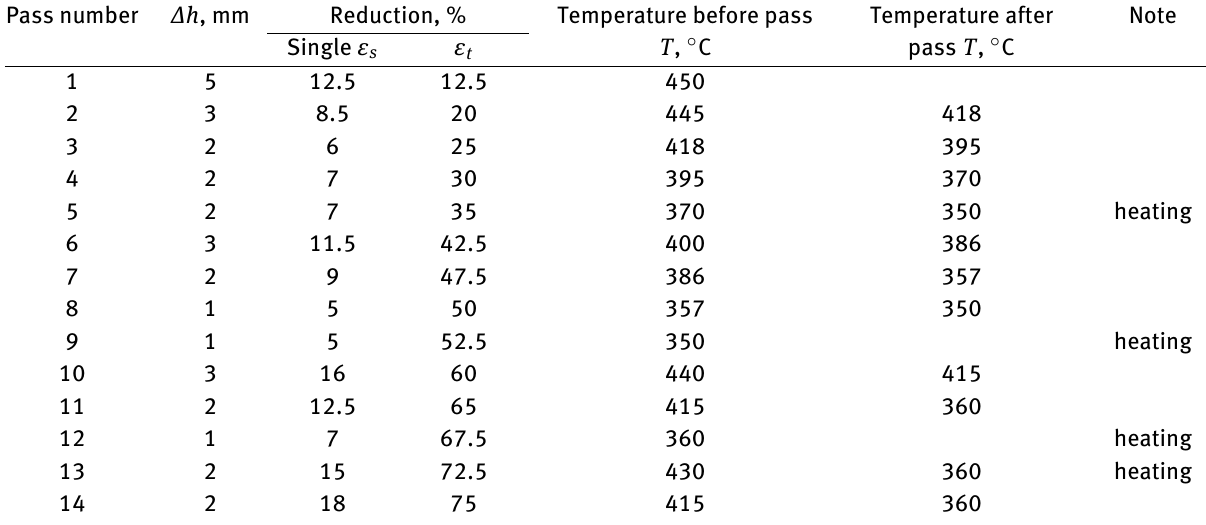
Table 4: Modes of reduction and temperature of metal along the passes during rolling